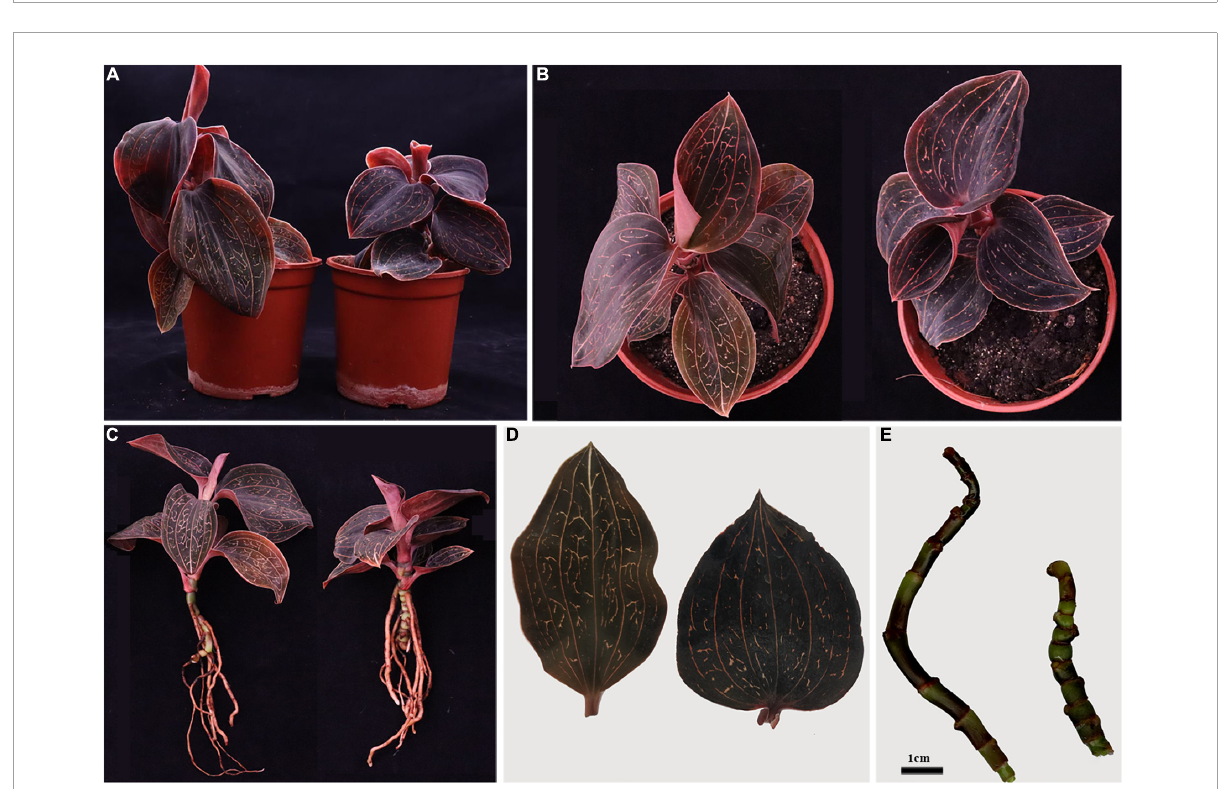
FIGURE2 Morphological characteristics of diploid and tetraploid A. roxburghii : whole plants (A–C) , leaves (D) and stems (E) . Diploids on the left and tetraploids on the right in each